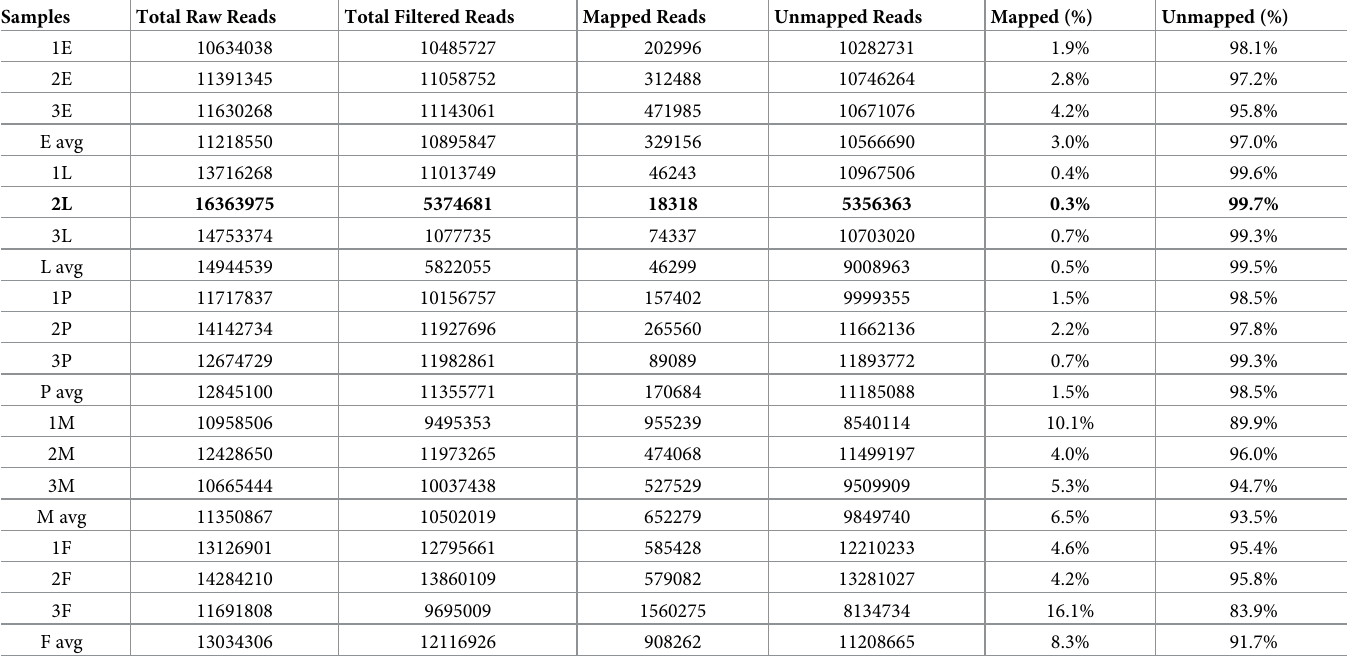
Table 1. Summary of BSF reads sequenced and mapped. Samples Total Raw